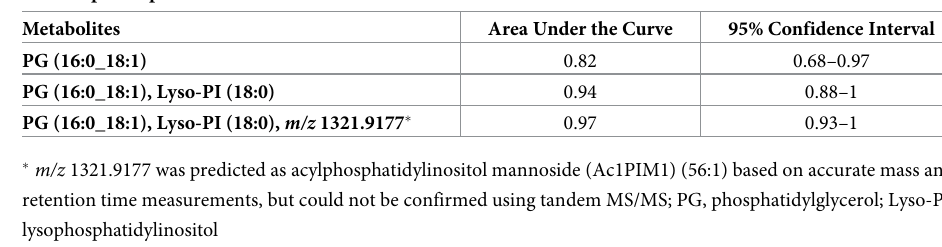
Table 2. Area under the receiver operator characteristic curve for varying combinations of Mycobacterium tuber- culosis lipid